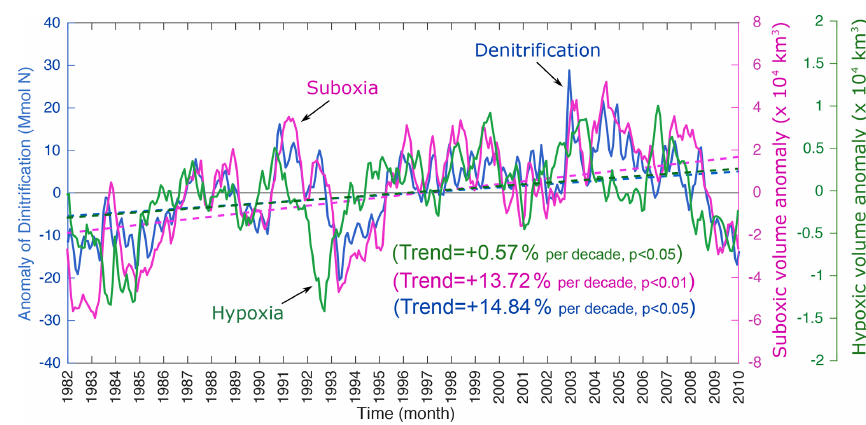
Figure 5. Changes in oxygen minimum zone and denitrification in the northern AS. Interannual anomalies in the volume of suboxia (purple), hypoxia (green) and water column denitrification (blue) in the upper 1000m north of 20 ◦ N over the study period. The dashed lines indicate the trend lines. The location of the northern AS box is shown in Fig. 4a.